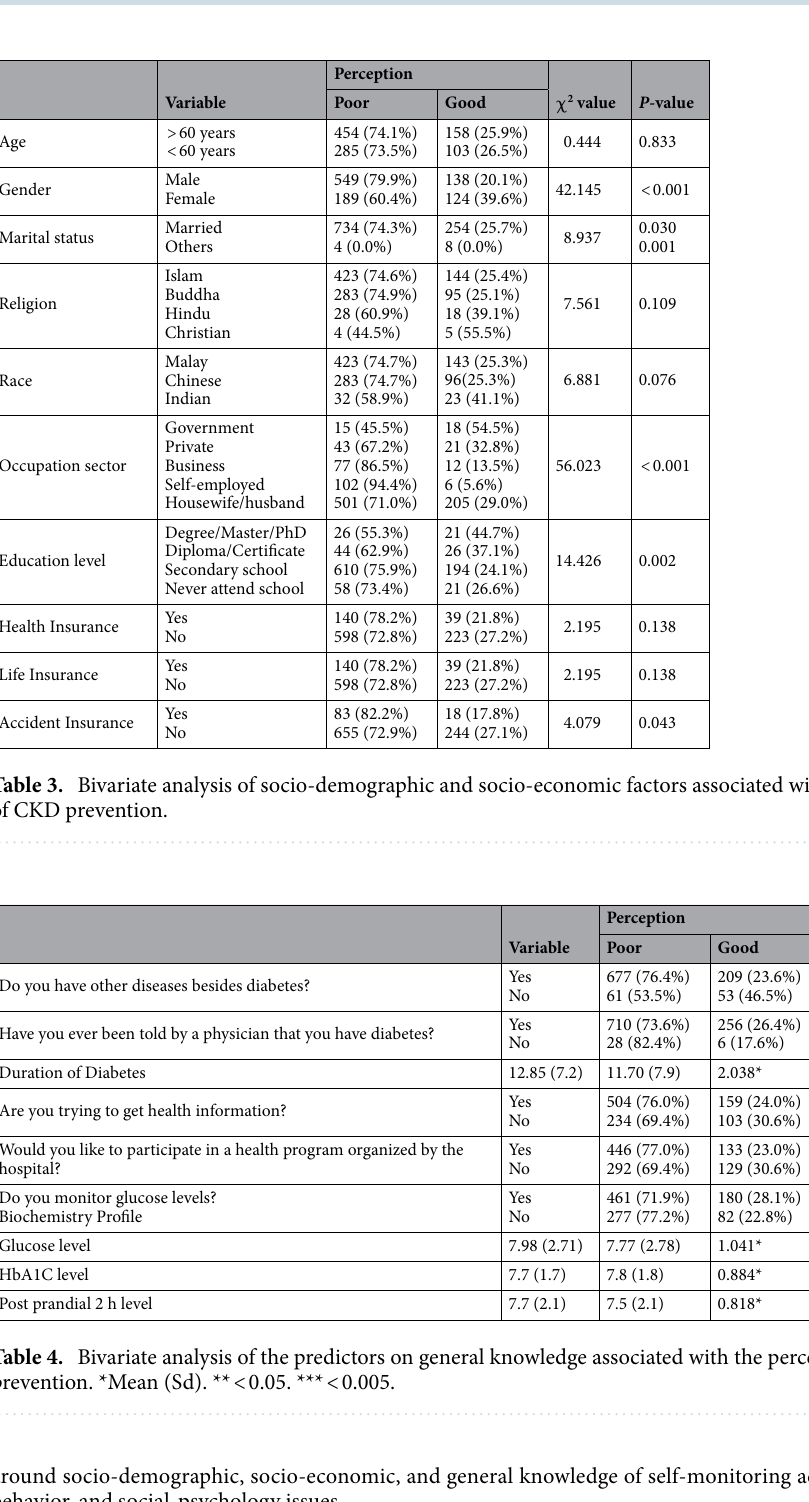
Table 4. Bivariate analysis of the predictors on general knowledge associated with the perception of CKD prevention. *Mean (Sd). ** < 0.05. *** < 0.005.